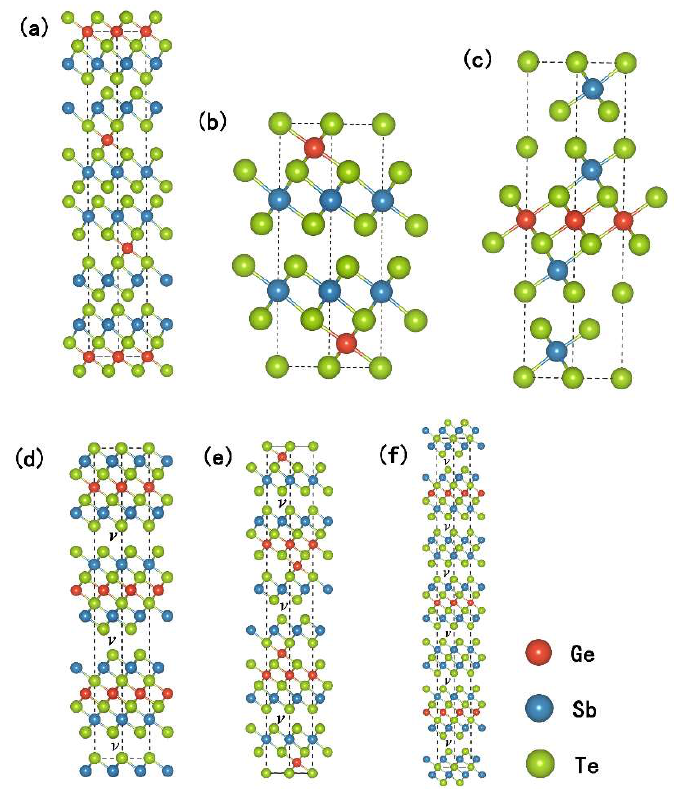
Figure 1. Structures for m GeTe • n Sb 2 Te 3 phases: ( a ) stable Ge 1 Sb 2 Te 4 , ( b ) stable Ge 2 Sb 2 Te 5 , ( c ) stable Ge 1 Sb 4 Te 7 , ( d ) meta-stable Ge 1 Sb 2 Te 4 , ( e ) meta-stable Ge 2 Sb 2 Te 5 , ( f ) meta-stable Ge 1 Sb 4 Te 7 , v represents a vacancy layer. The Ge (red balls), Sb (blue balls), and Te (green balls) are indicated.